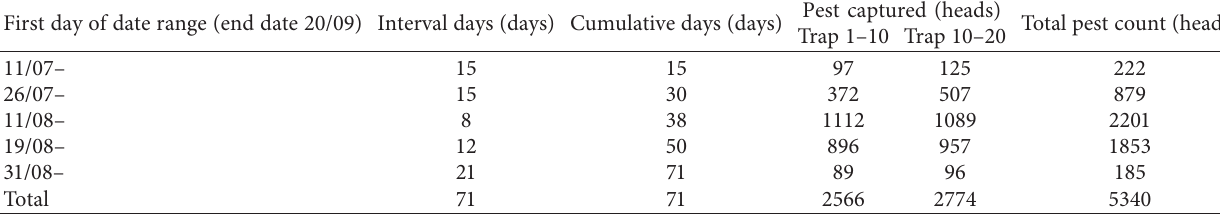
Table 2: The pest count of male rice stem borer captured using the paste lure of the synthetic sex pheromone blend in Jilin in